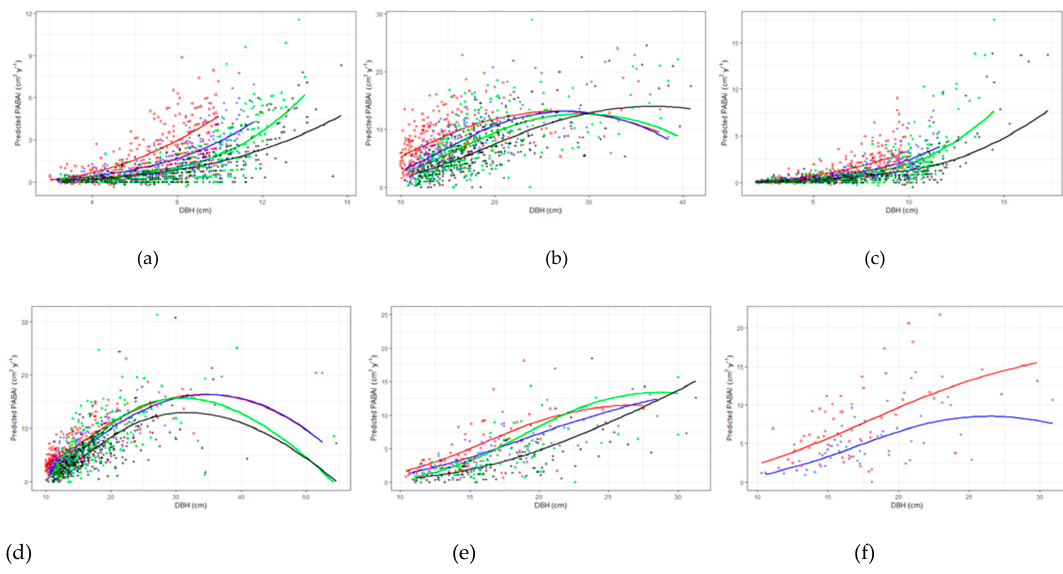
Figure A2. Predicted periodic annual basal area increment versus DBH using the fixed effects parameters of the base model (Equation 7) for ( a ) small interior Douglas fir in Block C; ( b ) large interior Douglas-fir in Block C; ( c ) small interior Douglas fir in Block D; ( d ) large interior Douglas-fir in Block D; ( e ) large spruce in Block D; and ( f ) large PL in Block D. The red, blue, green, and black lines represent predicted PABAI for 1993–1997, 1997–2004, 2004–2008, and 2008–2013 growth periods, respectively. The red, blue, green, and black symbols represent the measured PABAI for the same periods.